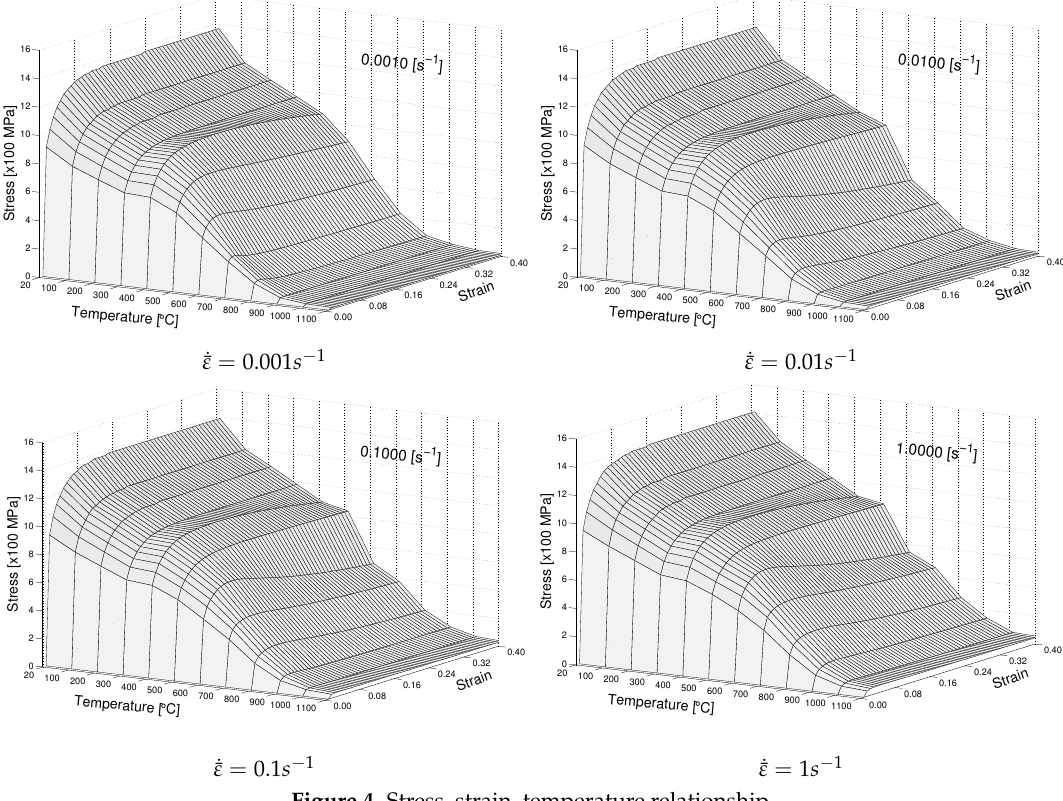
Figure 4. Stress–strain–temperature